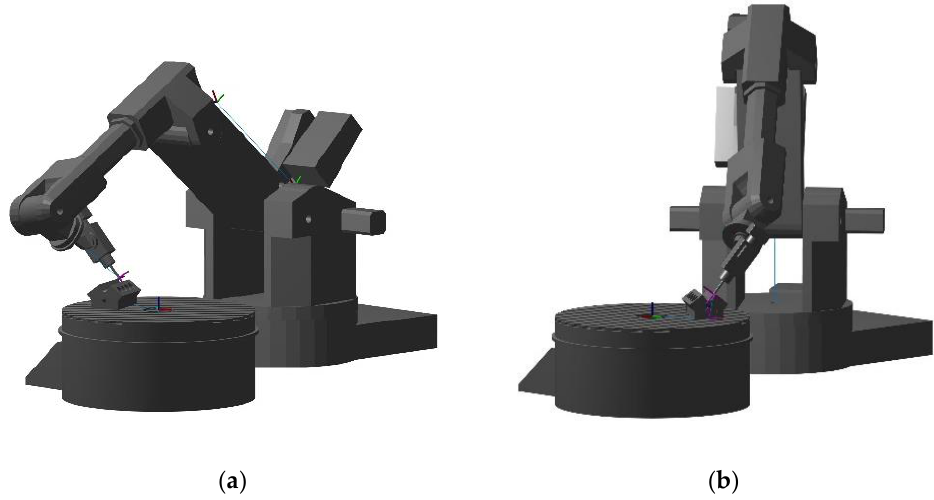
Figure 11. Traverse between ( a ) the left side and ( b ) the right side of the engine